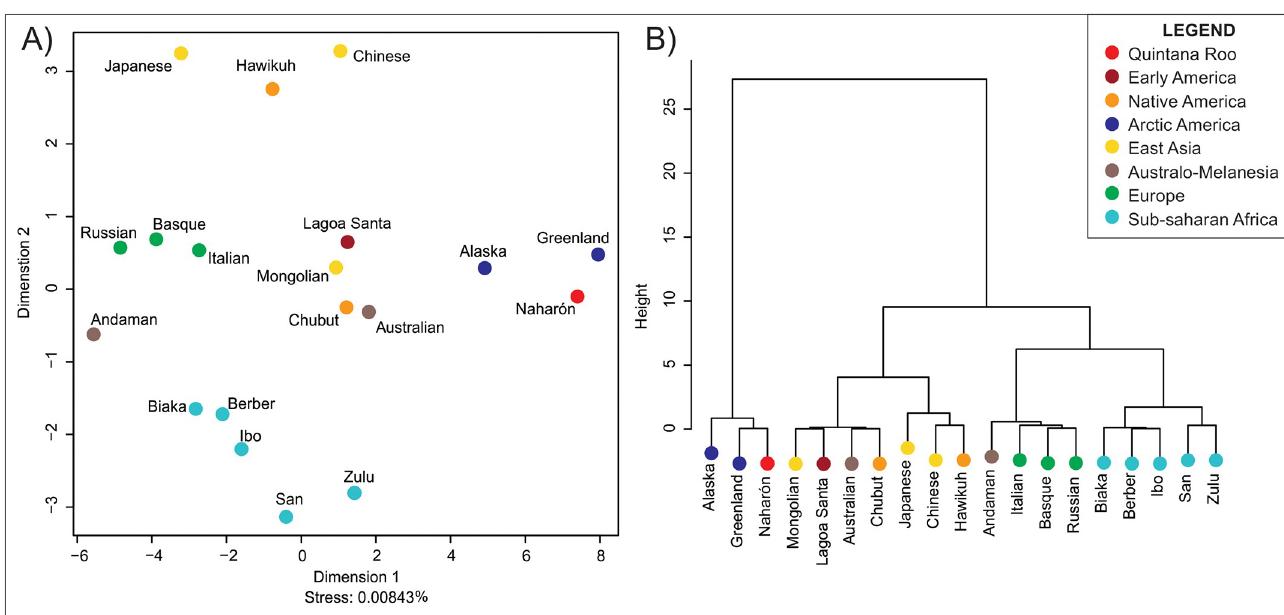
Fig 3. Morphological affinities between Naharo´n and reference series according to Mahalanobis distances of the first two Principal components. A) Multidimensional Scaling. B) Ward’s Cluster.